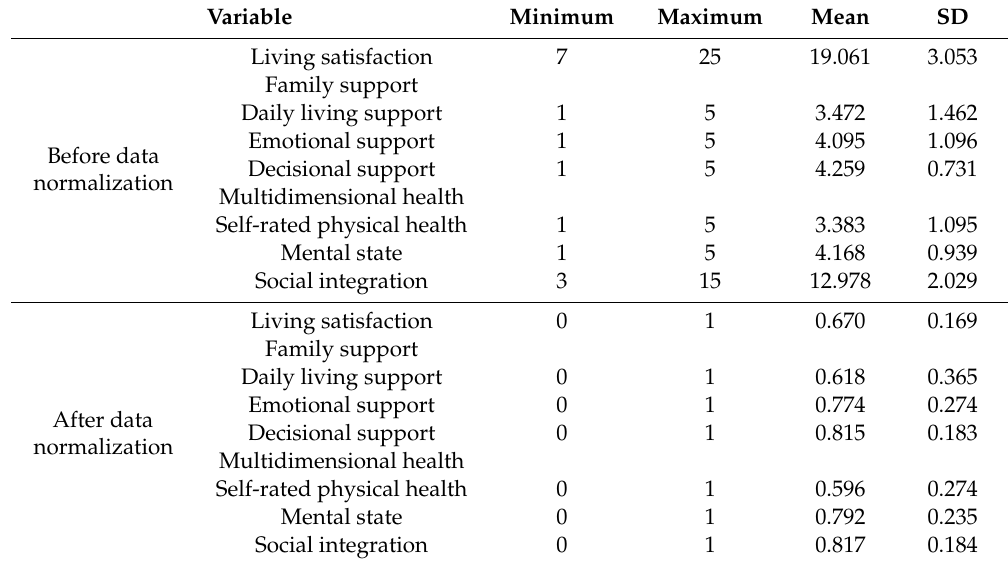
Table 3. Living satisfaction, family support, and heath characteristics of the